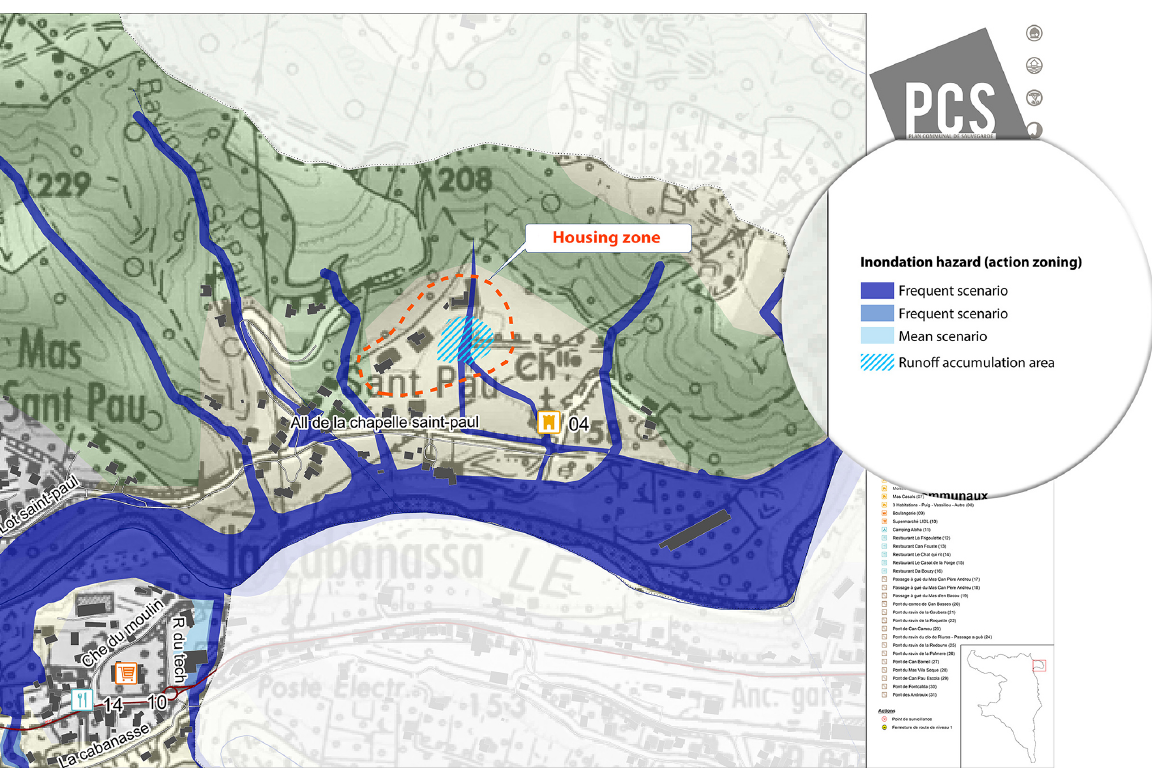
Figure 6. Extract of operational flooding zoning included in the PCS (Municipality Safeguard Plan). Reynes (66).